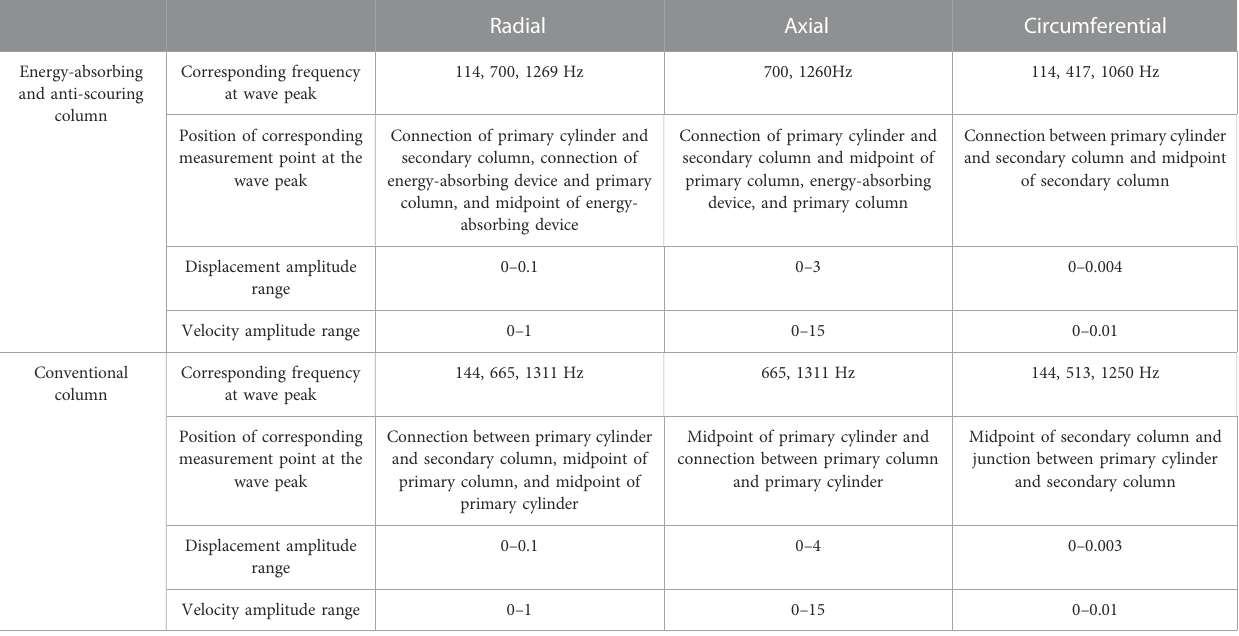
TABLE 11 Comparison of column harmonic response analysis